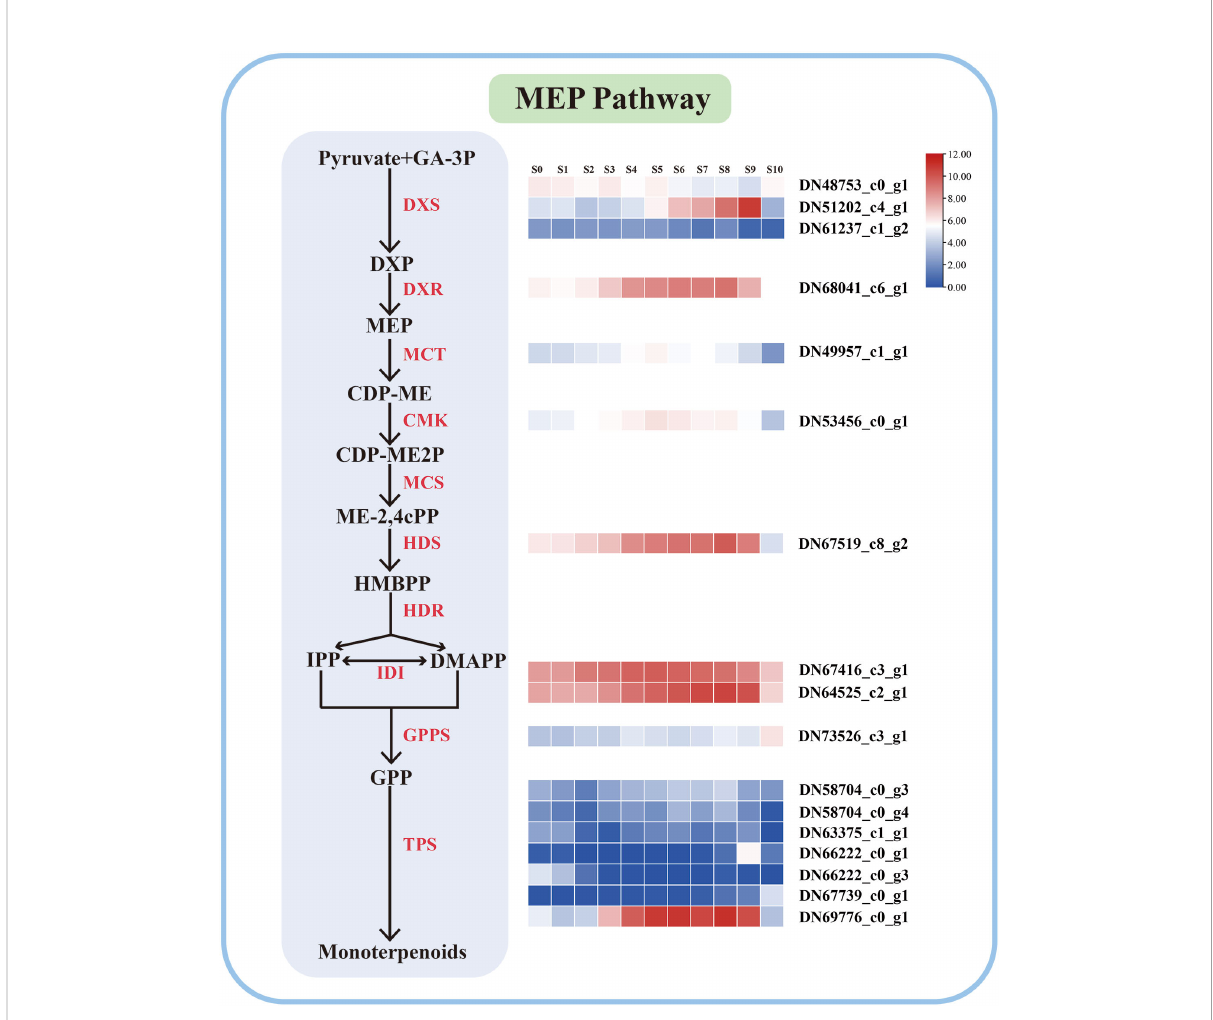
FIGURE 2 Expression pro fi les of the genes encoding enzymes involved in monoterpene biosynthesis. The change in bar color from blue to red indicates an expression change from low to